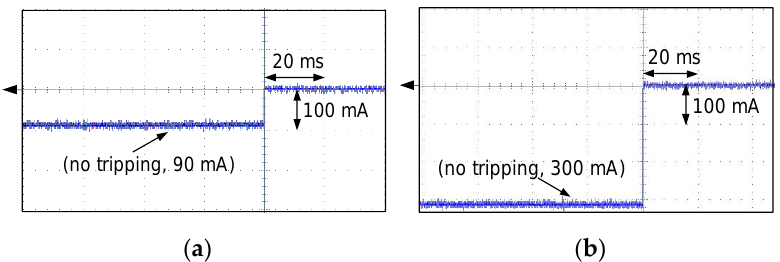
Figure 28. Oscillograms of the DC current flow during NO tripping of the F-type RCD (RCD30_5). Suddenly applied DC current of the following values: ( a ) 90 mA; ( b ) 300 mA.